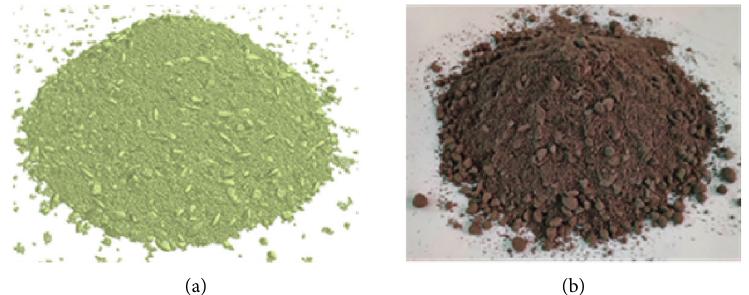
Figure 13: Test results. (a) Simulation test diagram. (b) Field test